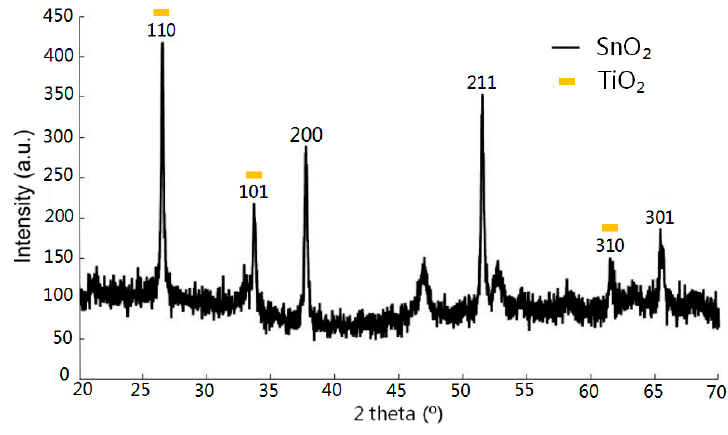
Figure 6. XRD pattern of SnO 2 thin film deposited on FTO/TiO 2 substrate.